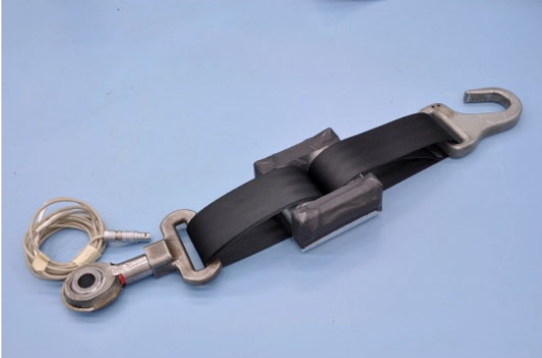
Figure 11. Surrogate WTORS.